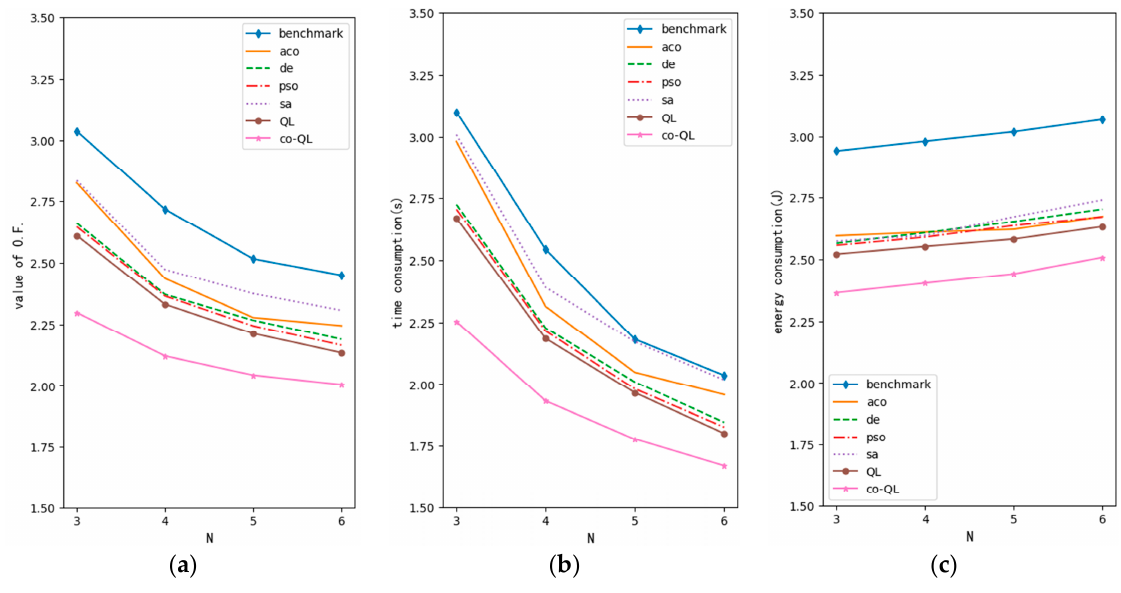
Figure 8. Optimization performance curve of variable N (M = 3, G = 1): ( a ) curve for value of objective function; ( b ) curve for time consumption; ( c ) curve for energy consumption.